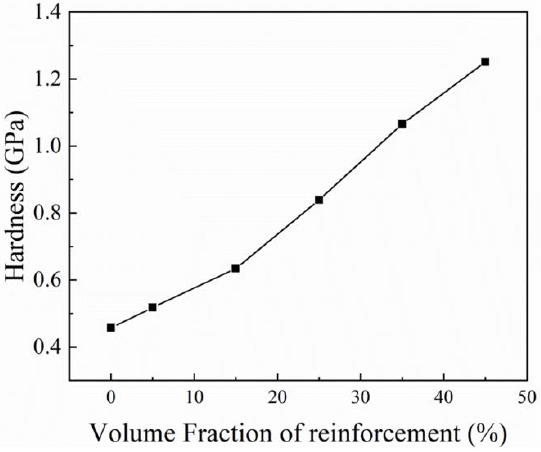
Figure 10. Hardness of AlN/Al gradient composite with different volume fractions.